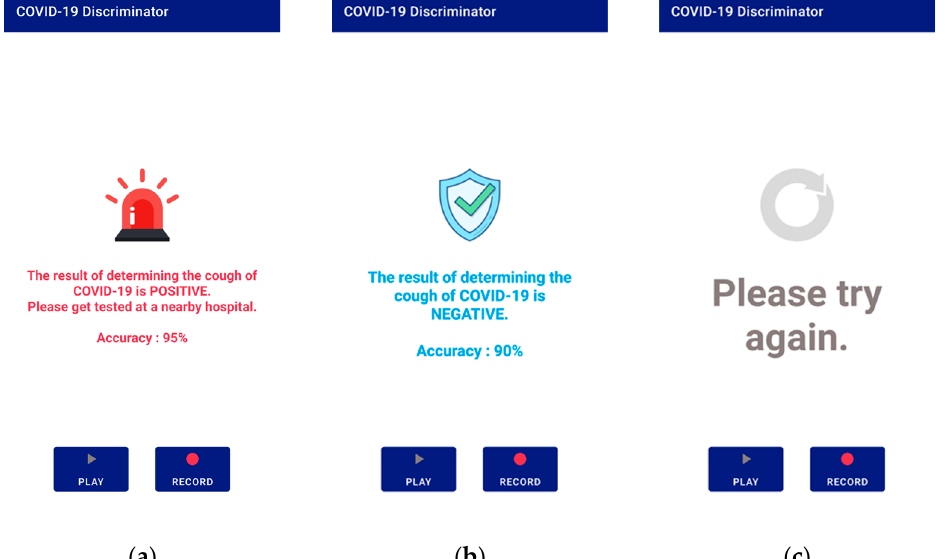
Figure 7. Application screen 2: ( a ) positive result; ( b ) negative result; ( c ) if no cough is detected.